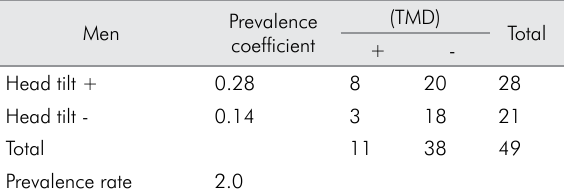
Table 3. Distribution of the number of men with (+) or without (-) TMD and head